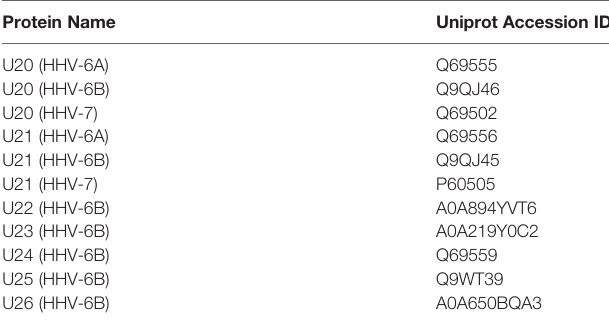
TABLE 3 | Roseolovirus protein sequences referenced in this